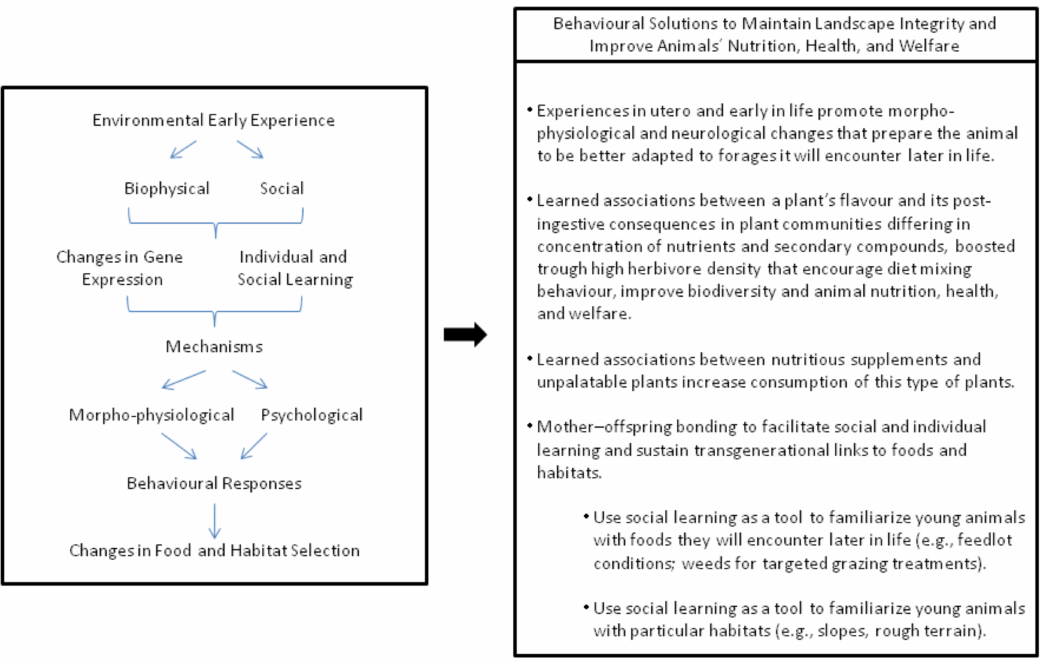
Figure 1. Conceptual framework on the influence of experience with biophysical and social environments in the development of food and habitat preferences by ruminants, and derived behavioural solutions for the well-being of animals, plants, and